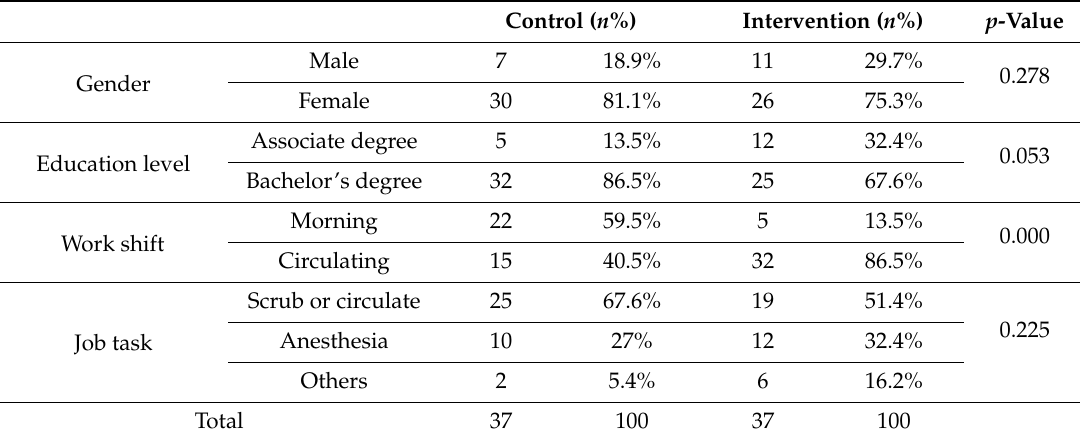
Table 2. Other demographic characteristics of the subjects in the